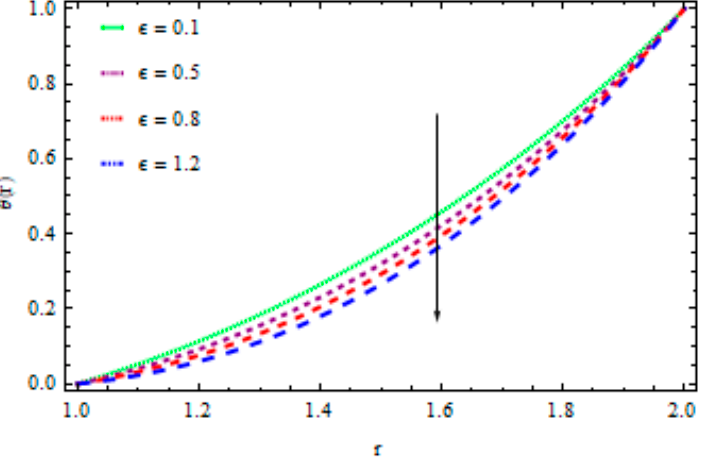
Figure 7. The influence of Figure 7. The influence of Q on velocity distribution for Vogel’s model when B r = 0.2, B Coatings 2020 , 10 , x FOR PEER REVIEW N = 0.3, D = 0.2, Ω = 1.0, K p = 0.2.